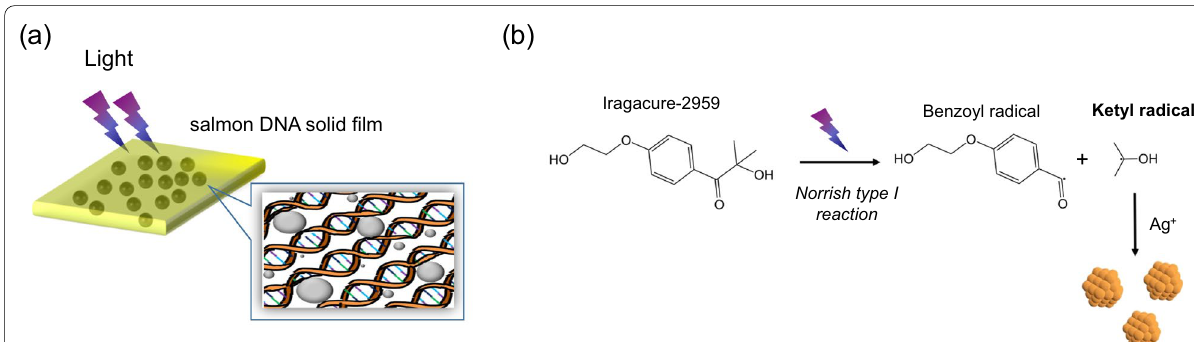
Fig. 1 a Illustration of phototriggered DNA metallization in a solid matrix b Under UVA light, the photoinitiator I‑2959 produces free ketyl radicals via Norrish‑type‑I α ‑cleavage. The ketyl radicals function as reducing agents for the reduction of silver